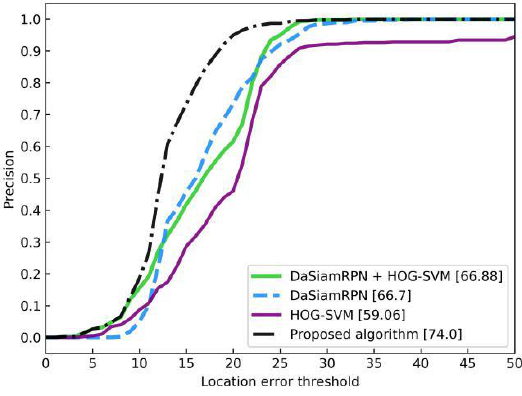
Figure 14. The precision plots of Video Sequence II.